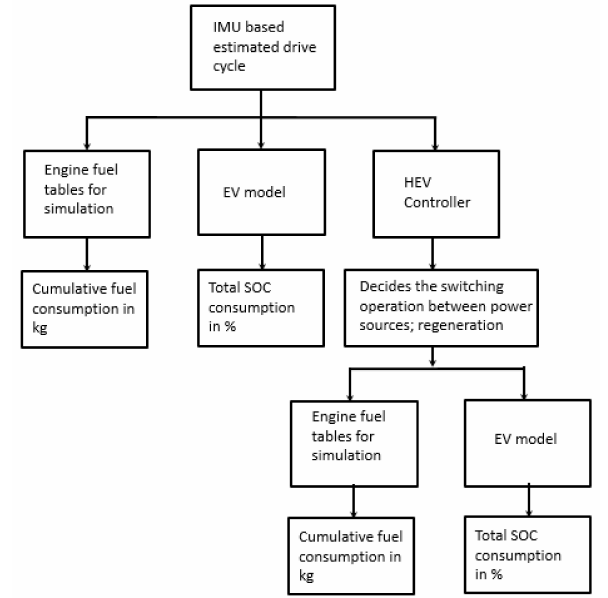
Figure 2. Flowchart of the current work explaining the outline of the